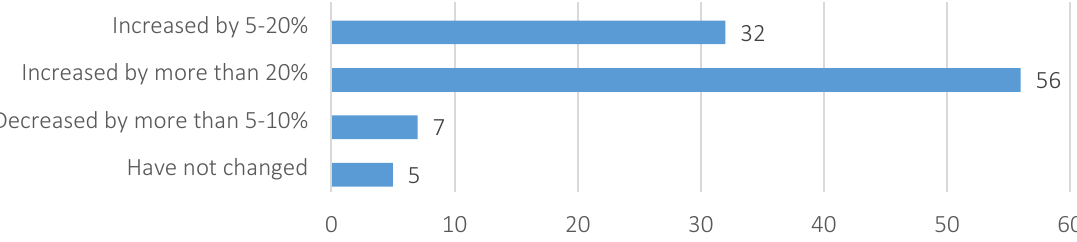
Figure 3. Changes in expenses of the hospitality industry during the Russian-Ukrainian war